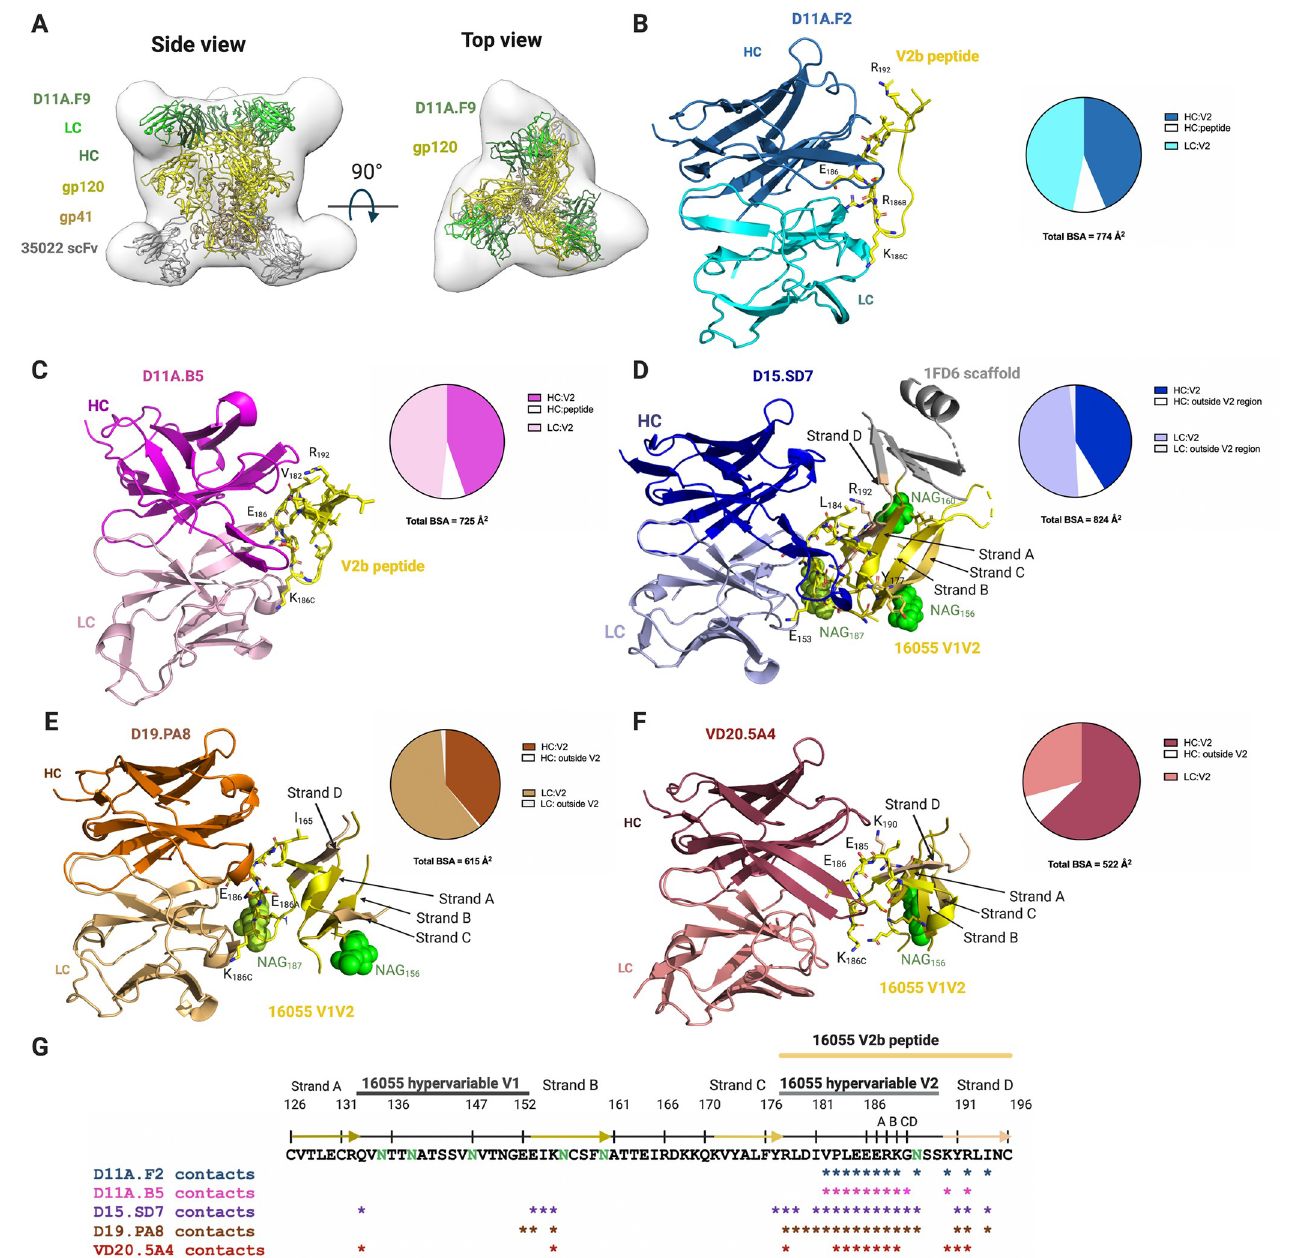
Fig 2. Vaccine-elicited antibodies recognize the V2 region of 16055 strain. (A) nsEM 3D reconstruction with low resolution crystal structure of D11A.F9 Fab (Heavy chain, dark green; Light chain, light green) and 35022 scFv (gray) in complex with 16055 NFL (gp120, yellow; gp41, light brown) shown in two different views. ( B, C) Structures of D11A.F2 Fab (Heavy chain, sky blue; Light chain, cyan) and D11A.B5 Fab (Heavy chain, magenta; Light chain, light pink) bound to the V2b peptide (yellow). ( D) Structures of D15.SD7 (Heavy chain, blue: Light chain, light blue), (E) D19.PA8 (Heavy chain, orange; Light chain, light orange) and (F) VD20.5A4 (Heavy chain, raspberry; Light chain, light raspberry) Fabs in complex with the 16055 V1V2-1FD6 scaffold. ( B, C, D, E, F ) Interacting residues are shown in sticks and glycans in green. Pie charts summarize the buried surface area (BSA) of the V2b and V1V2-1FD6. ( G) Sequence of 16055 V1V2 highlighting the V2b peptide used for crystallization, the location of the V1, V2 and strands. Residues that contact the Mabs (within 5 Å ) are shown with asterisks underneath the sequence. N-linked glycosylation sites are shown in green.